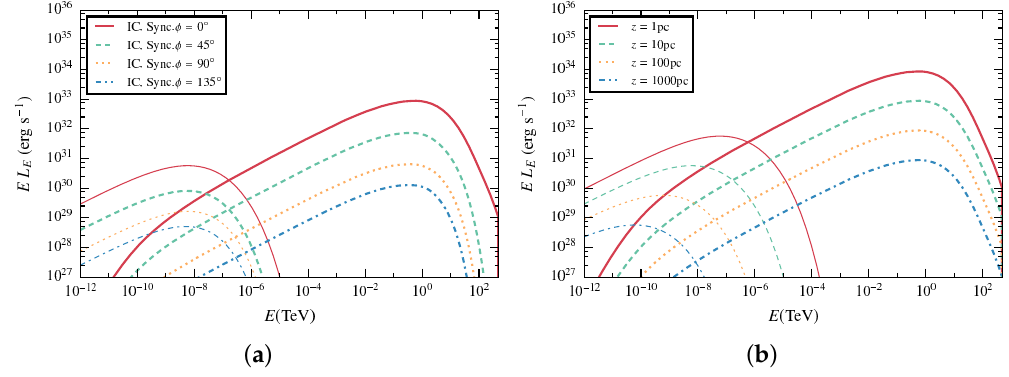
Figure 8. ( a ) Resulting spectral energy distributions (SED), including synchrotron and IC radiation, of the equilibrium state in a jet-star (red giant, ˙ M w = 10 − 9 M (cid:12) /yr) interaction at 10 pc from the central engine for a weakly magnetized jet, as derived from different viewing angles [151]. An increase of the magnetization increases strongly the synchrotron flux but barely affects the IC radiation. ( b ) Same as ( a ), but for a fixed viewing angle of φ = 0 ◦ and different interaction locations along the jet. The farther from the central engine, the weaker the resulting